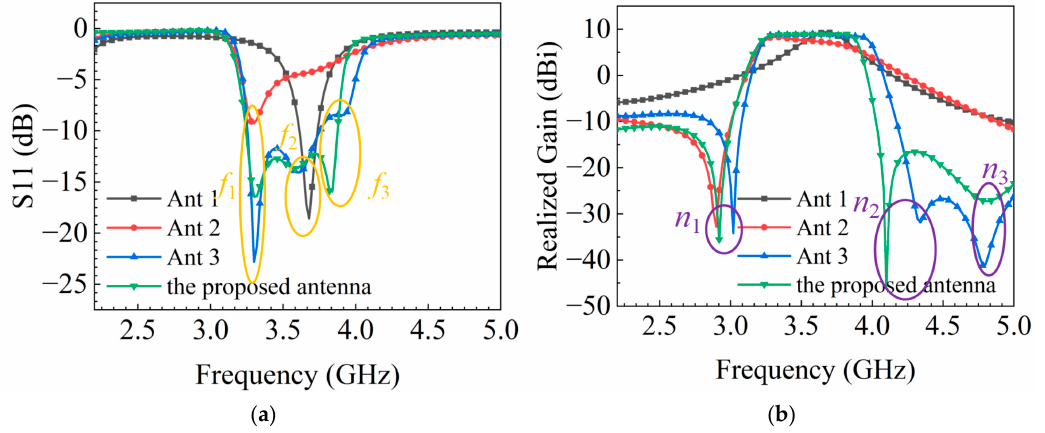
Figure 4. Simulated results for the reference and proposed antennas. ( a ) S11; ( b ) realized